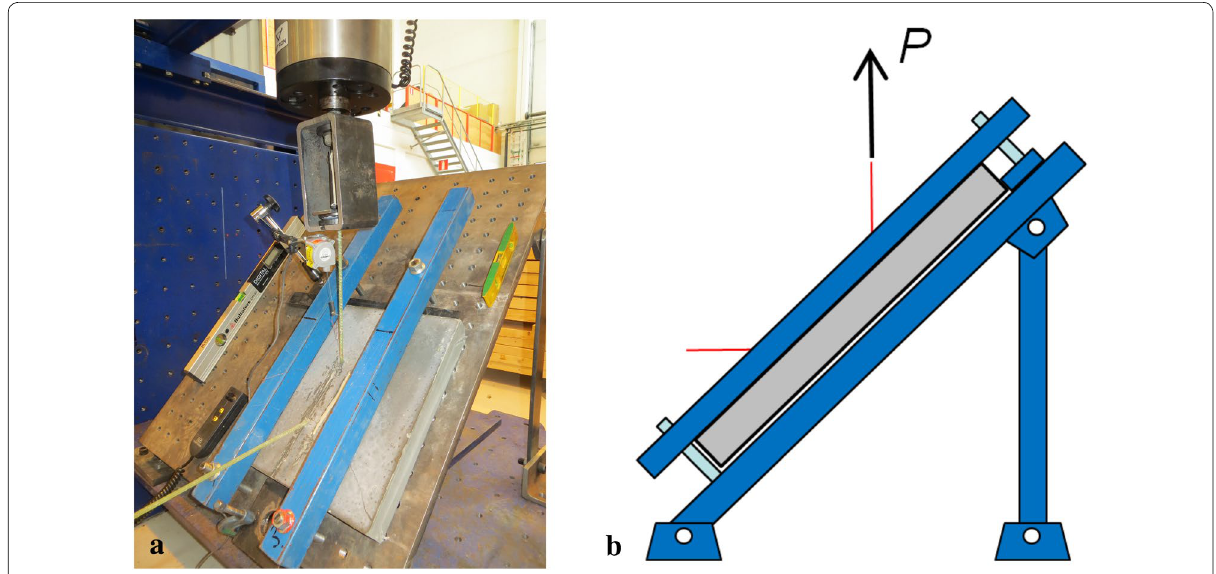
Fig. 6 Pull-out test setup ( a ) and schematic of load transfer to connector ( b